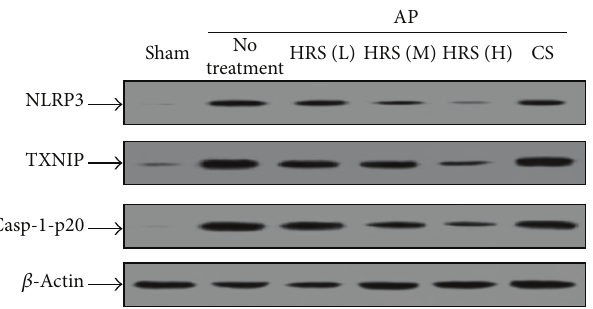
Figure 1: Evaluation of pancreatic NLRP3 inflammasome activation in mice by Western blot assay. The HRS at various doses or control saline (CS) was injected intraperitoneally to AP mice 1h after the final injection of cerulein, respectively. Twenty-four hours later, animals in each group ( 𝑛 = 6 ) were killed and the pancreatic tissue samples were immediately collected and then homogenized on ice. After the measurement of protein concentration, the NLRP3 inflammasome activation was evaluated by detecting the protein levels of TXNIP, NLRP3, and casp-1-p20 in pancreatic homogenates. L: low dose (2mL/kg × 3); M: middle dose (4mL/kg × 3); H: high dose (8mL/kg ×